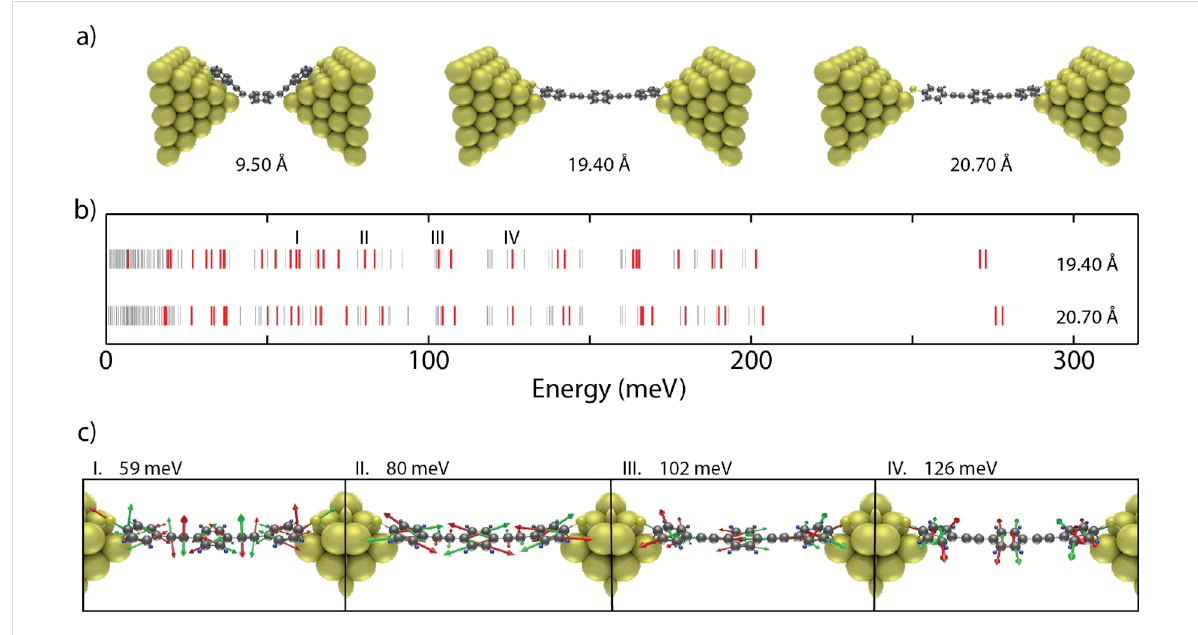
Figure 5: (a) Three selected geometries along the stretching of the junction. (b) Calculated vibrational spectra for an electrode displacement of 19.40 Å (top) and 20.70 Å (bottom). (c) Vibrational modes responsible for the peaks I–IV in (b).